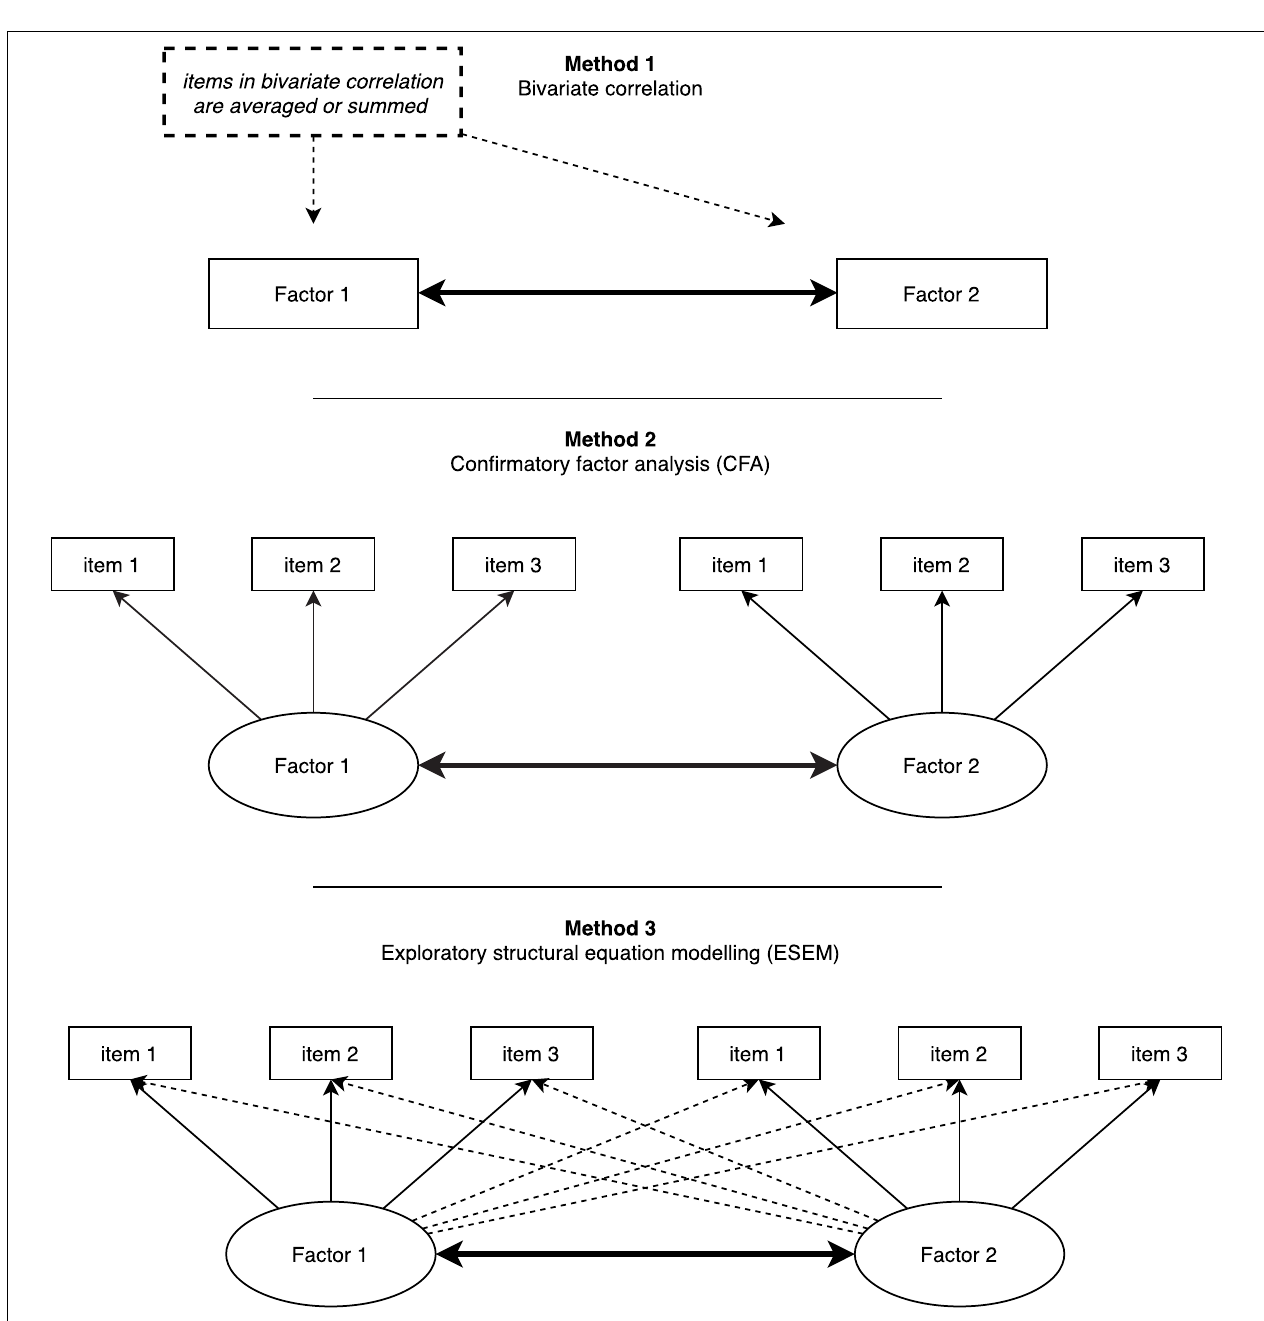
FIGURE 1 | Visual representation of the correlation in bivariate correlation, CFA, and